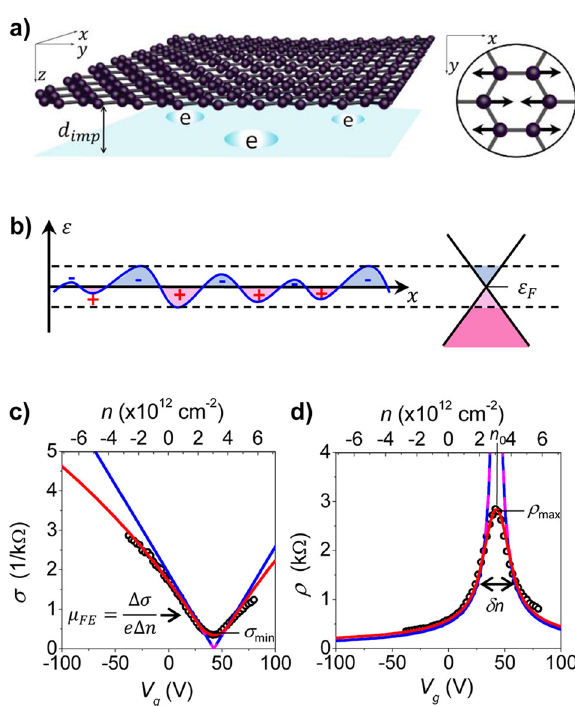
Fig. 1 Convolution model. a Schematic diagram showing the impurity position with respect to the graphene sheet and a pictorial representation of spatio-temporal (angular frequency, ω ) phonon oscillations over one unit cell. b Spatial inhomogeneity in the impurity potential and the resulting broadening of the energy distribution of electrons and holes near the Fermi level (Dirac cones). Conductivity ( c ) and resistivity ( d ) of graphene plotted vs. gate voltage. Field effect mobility, μ FE , is estimated from the gradient of σ ( V g ) dependence. Circles show experimental data, blue lines show linear fi ts, using Eq. (1), dashed pink curves are fi ts to the data found by including a short-range scattering resistivity, and red curves result from the convolution fi